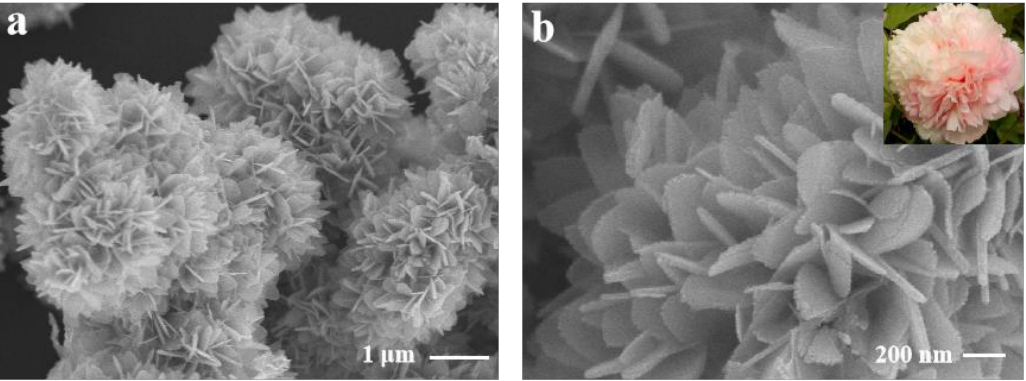
Figure 2. ( a ) SEM image of BiVO 4 -7 and ( b ) corresponding high-magnification image. The valence state and surface chemical composition of BiVO 4 -7 were characterized by XPS. The survey spectrum confirmed the presence of V, Bi, and O in BiVO 4 -7 (Figure 3a). The peaks at 163.7 and 158.4 eV were attributed to the spin-orbit splitting of Bi 4f 5/2 and Bi 4f 7/2 , respectively (Figure 3b). The 5.3 eV spacing between the Bi 4f 5/2 and Bi 4f 7/2 peaks indicated a +3 valence state of Bi for an isotype heterojunction sample, as has been previously reported [29].